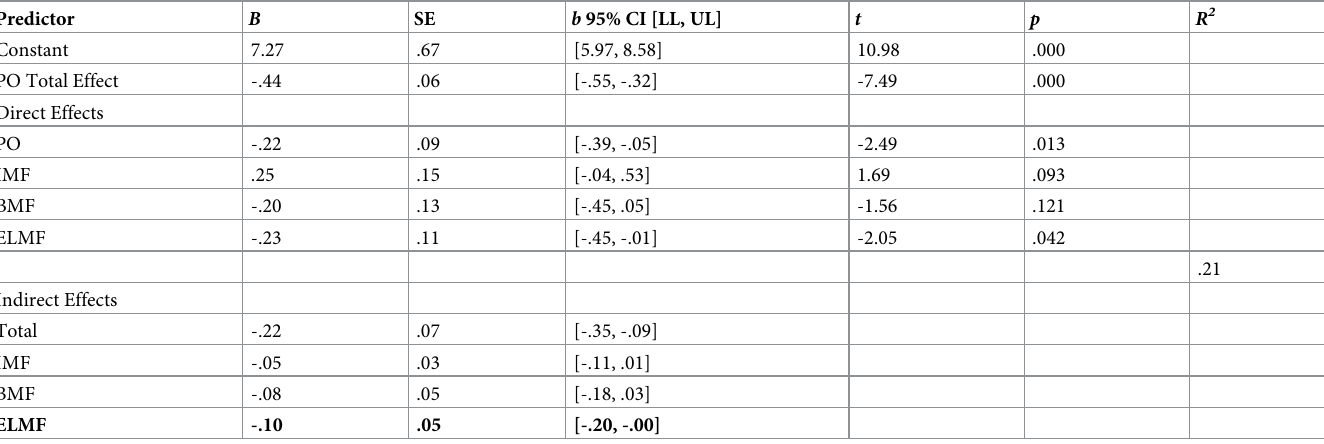
Key: PO: Political Orientation; IMF: Individualizing Moral Foundations; BMF: Binding Moral Foundations; ELMF: Economic Liberty Moral Foundation. Significant indirect (mediation) effects indicated in bold font.